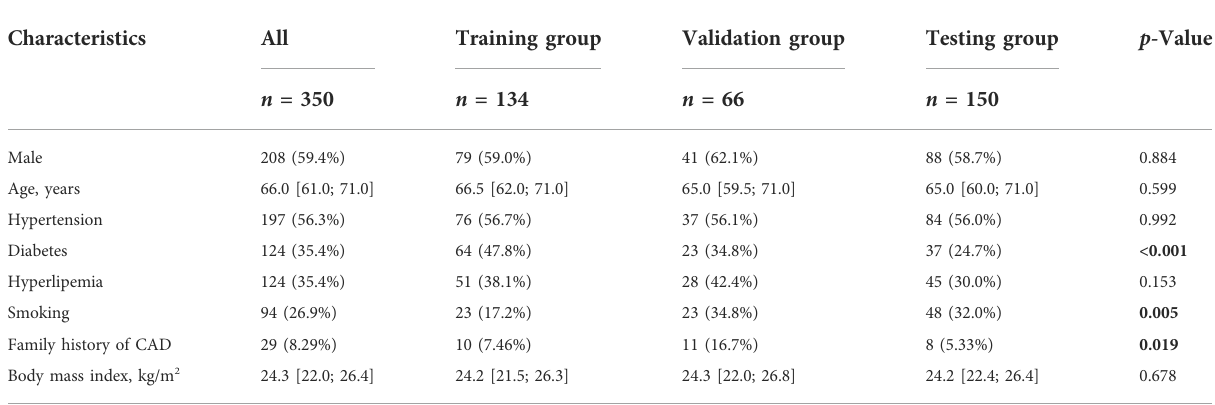
TABLE 1 Clinical